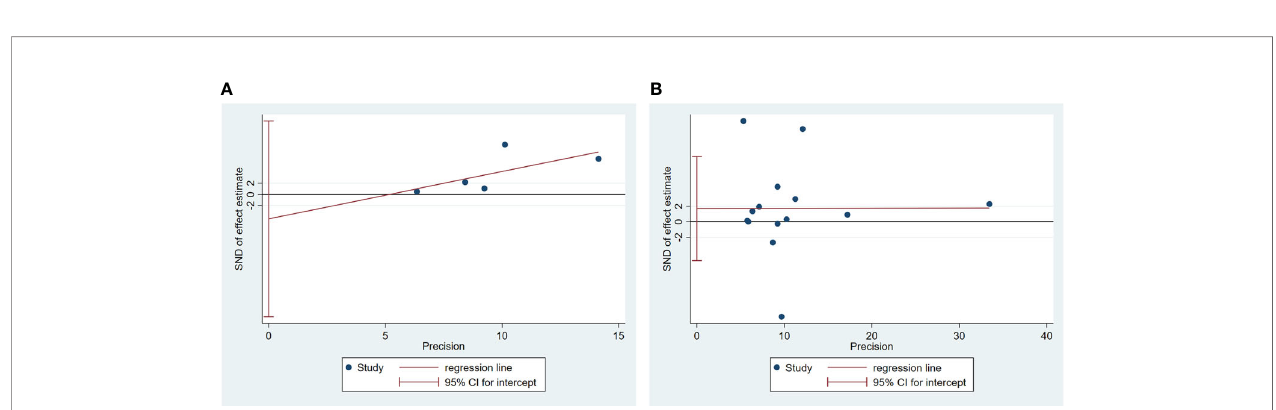
FIGURE 7 | Egger ’ s linear regression for publication bias about association between C-peptide (A) or insulin (B) and breast cancer. Each circle represents a separate study pertaining to the indicated association. The circles imply that an asymmetrical distribution is not present, suggesting that no publication biases were